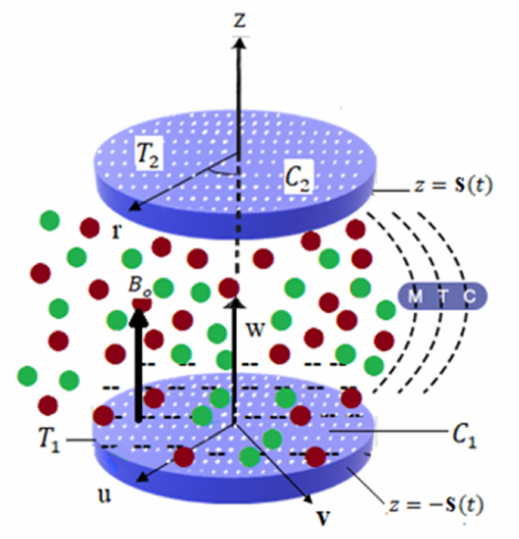
Figure 1. Physical